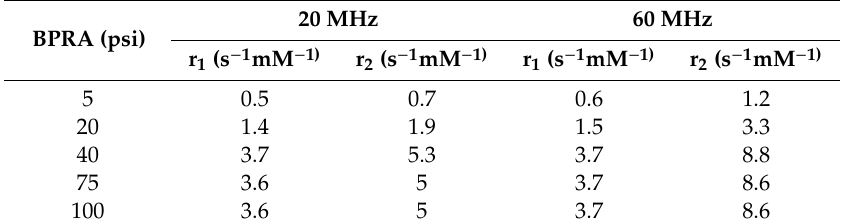
Table 1. Relaxometric properties of VSION obtained at di ff erent pressures.